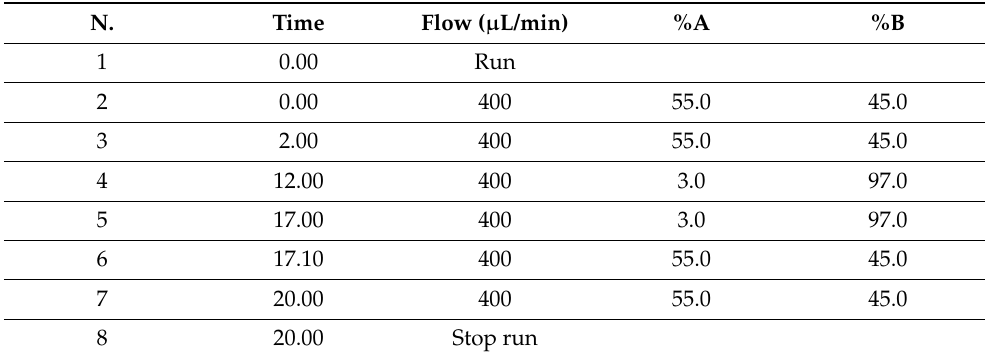
Table 1. Instrumental details for cutaneous lipidomics